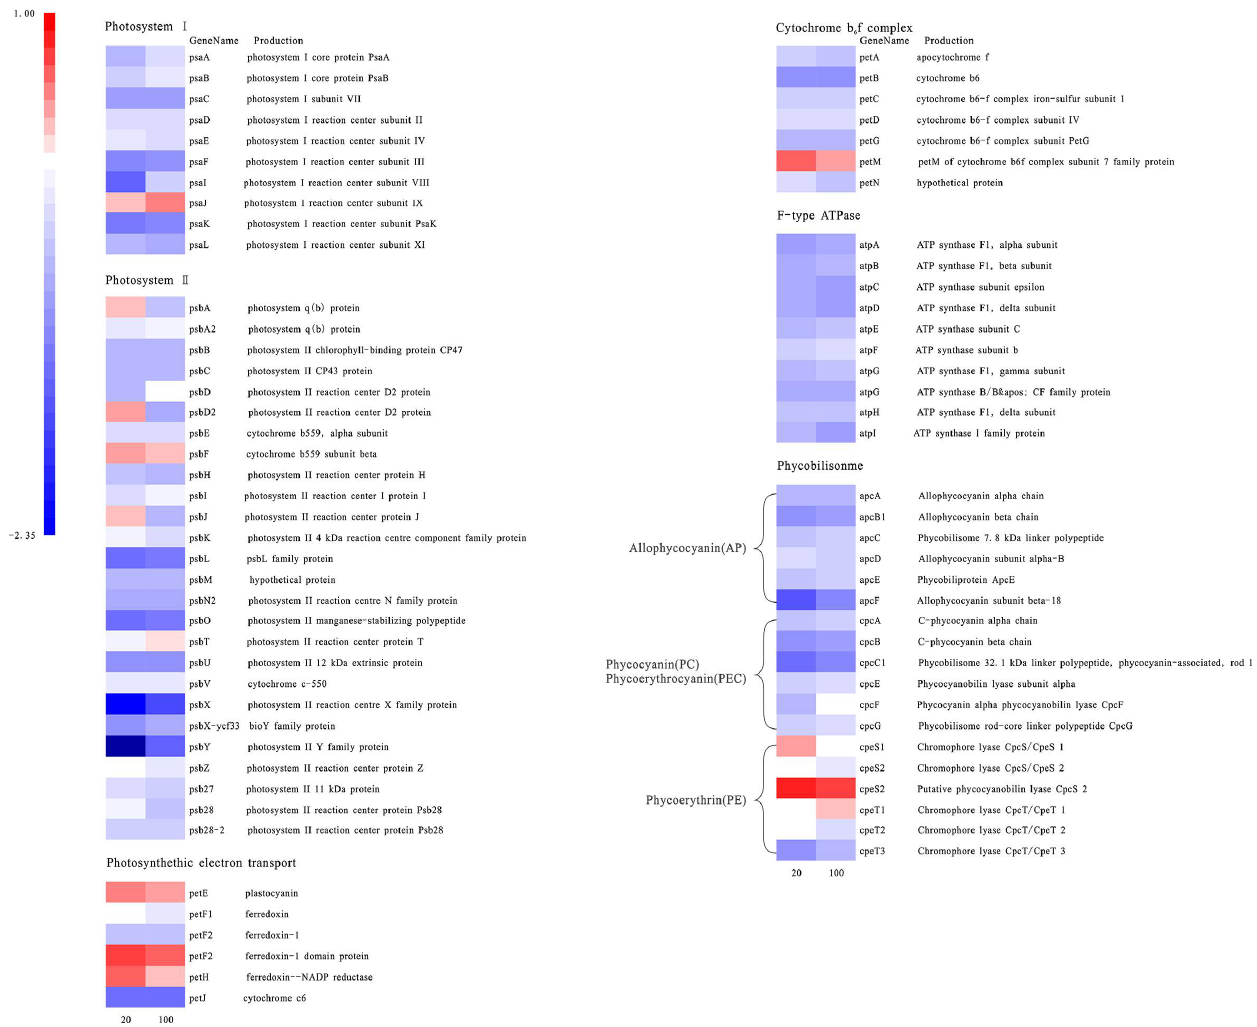
Figure 4. Gene expression heat map of photosynthesis-related genes. Blue corresponds to a decrease in transcript abundance, and red corresponds to an increase in transcript abundance. White means no difference from the control condition.